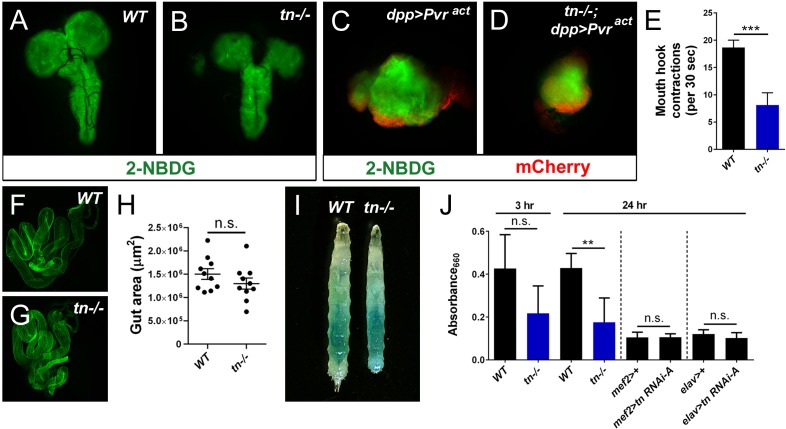
Glucose uptake and feeding behavior upon whole animal or tissue-specific loss of TRIM32.(A–D) Incubation of the fluorescent glucose analog 2-NBDG with isolated larval brains (A,B) or Pvract tumors (C,D) from L3 larvae show no visible difference in glucose uptake. (E) Mount hook contractions, a proxy for feeding behavior, is decreased in tn-/- larvae. N = 9. (F,G) Isolated L3 midguts from WT (F) or tn-/- (G) stained with phalloidin. (H) Quantitation of total midgut area is not significantly different between WT and tn-/-. N = 8. (I) L3 larvae after feeding dye for 24 hr. (J) Bar graph shows measured absorbance readings from L3 isolated midguts after for 3 hr or 24 hr of feeding. tn-/- show differential food intake, while tissue-specific knockdown of TRIM32 in muscle or brain after 24 hr does not alter food intake. Mean +/- SD. (***, p<0.005; **, p<0.01; n.s., not significant).